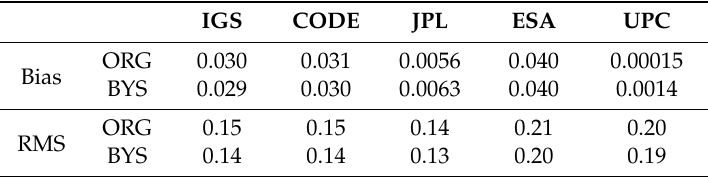
Figure 10. RMS of the differences in satellite DCBs between WHU products based on original LSE or Bayesian estimation, and the IGS final combined products or IAAC products. Table 3. Differences in satellites DCBs based on original LSE and Bayesian approaches compared with IAAC products (unit: TECU).